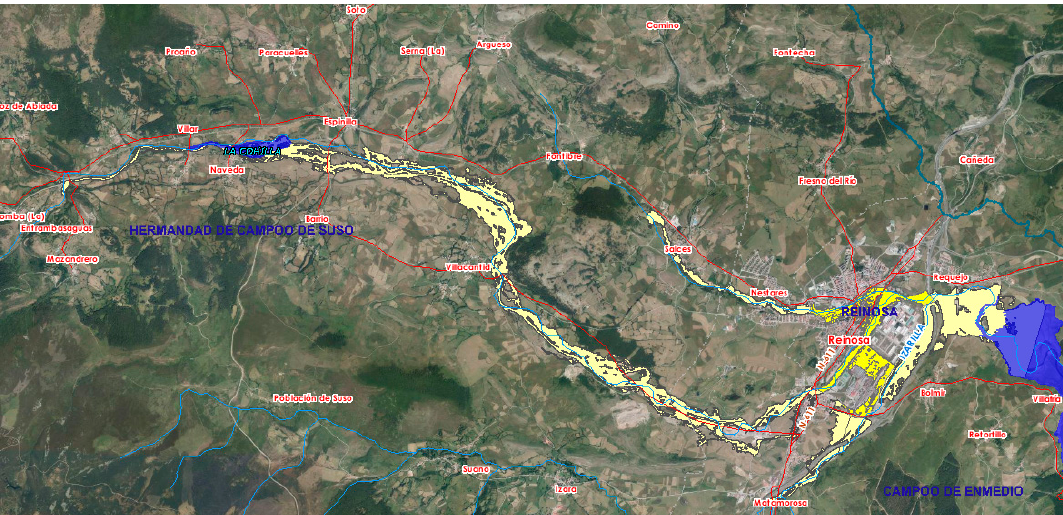
Figure 3. Hijar potential significant flood risk (ES091_HIJ_01_02_04_05_06). http://iber.chebro.es/SitEbro/sitebro.aspx.